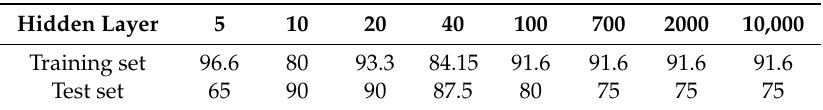
Table 7. Accuracy with different hidden layer (%).